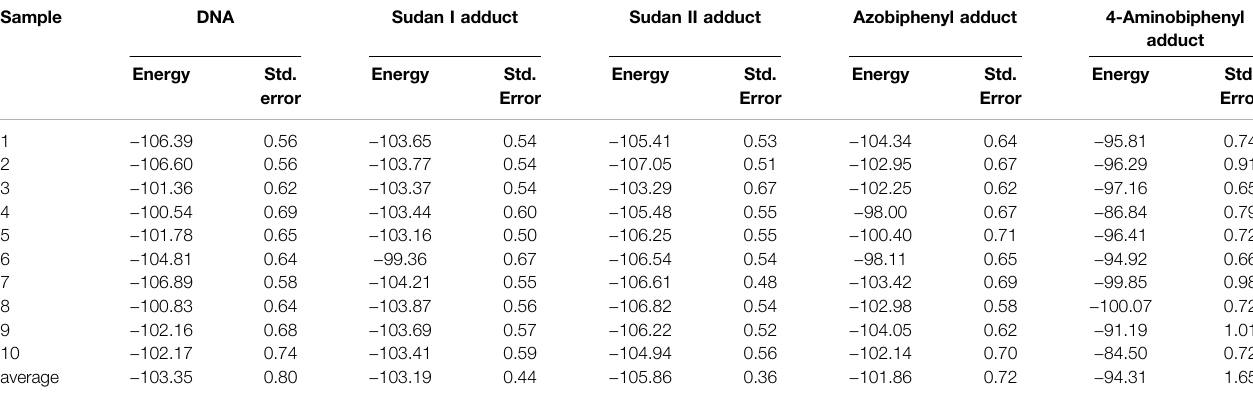
TABLE1| Freeenergies(inkcal/mol)ofinteractionbetweenthetwostrandsestimatedfromMM/GBSAcalculationsforeachDNAadduct.TheunalteredDNAsystemisused as the reference. A total of 100 con fi gurations collected at each nanosecond from 100 ns segments of each µs trajectory is considered as a sample, and the MMGBSA energies (and the standard errors) tabulated were averaged from the interaction energies of 100 con fi gurations per sample. The average energies and standard errors given in the last row were calculated from those ten samples.